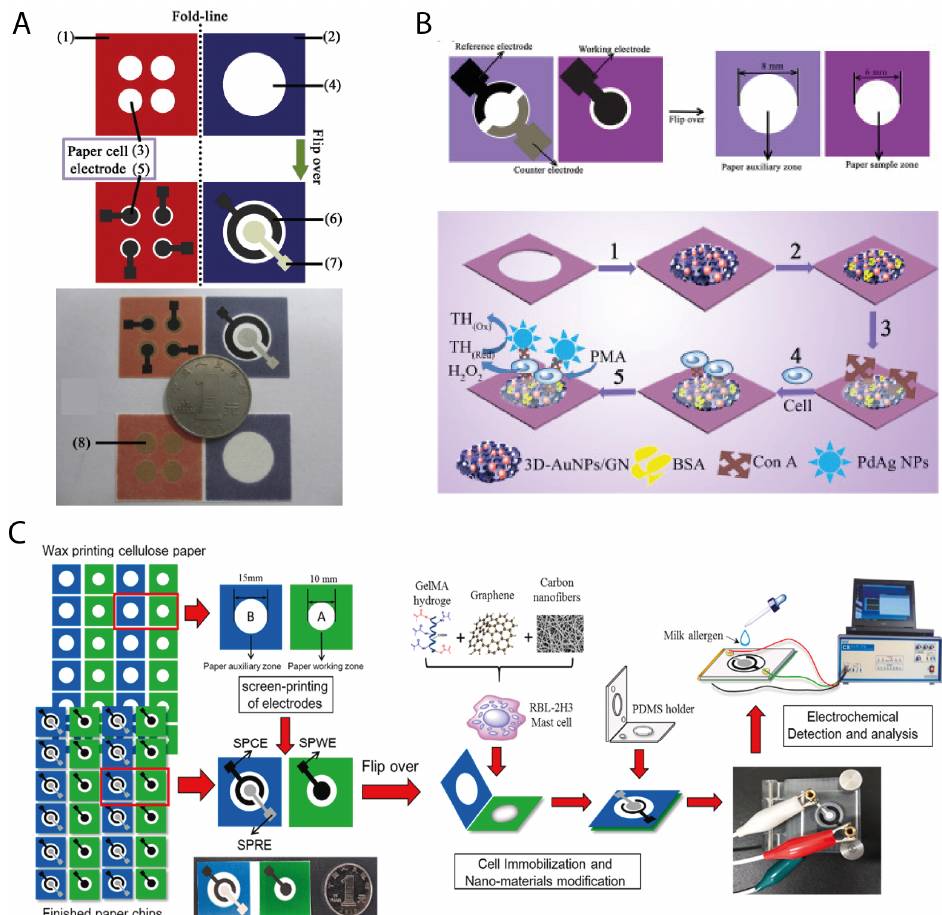
Figure 5. ( A ) Paper-based electrochemical cyto-device for sensitive detection of cancer cells and in situ anticancer drug screening. Reprinted with permission from [50], 2014 Elsevier; ( B ) electrochemical K-562 cells sensor based on origami paper device for point-of-care testing. Reprinted with permission from [51], 2015 Elsevier; ( C ) a novel electrochemical mast cell-based paper biosensor for the rapid detection of milk allergen casein. Reprinted with permission from [52], 2019 Elsevier.